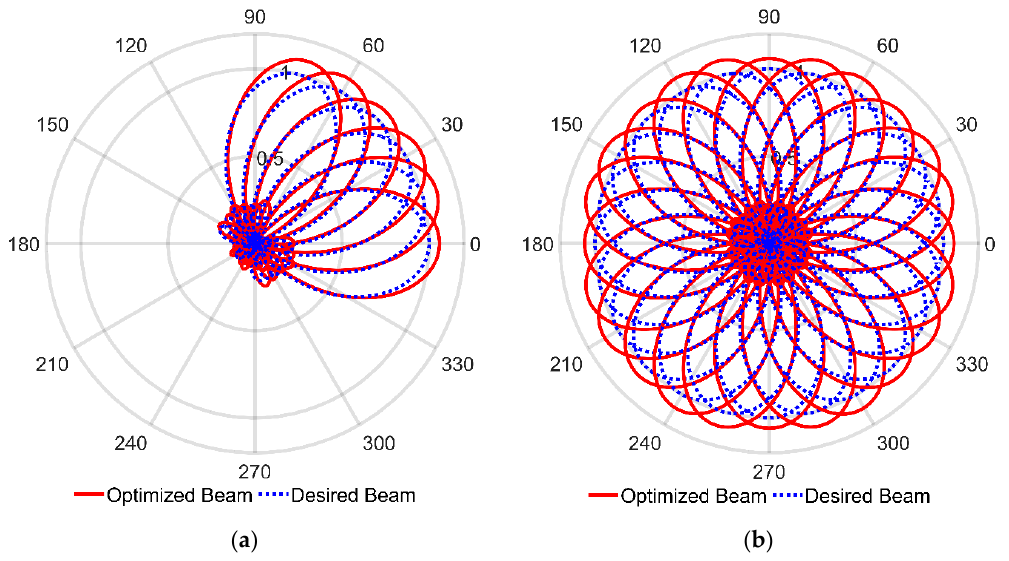
Figure 10. Beam Patterns of Two-Square Configuration 1: ( a ) Beam to 0°, 15°, 30°, 45°, 60°, and 75°, ( b ) Rotated beams.